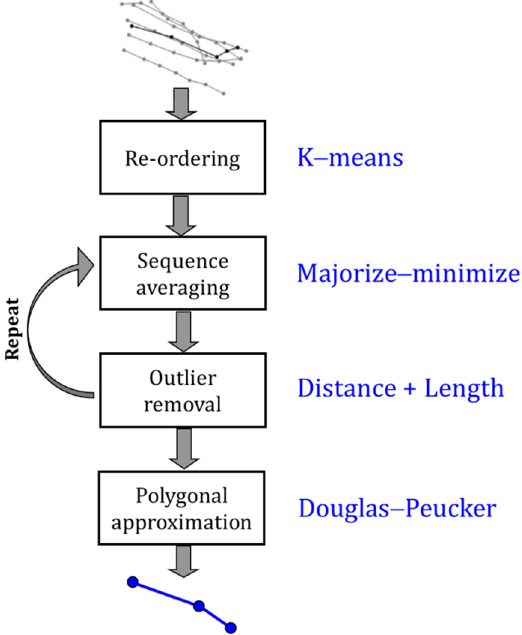
Figure 4. General structure of the methods from the segment-averaging competition [7]. A new baseline (shown by blue) was constructed by synthesis of these methods.